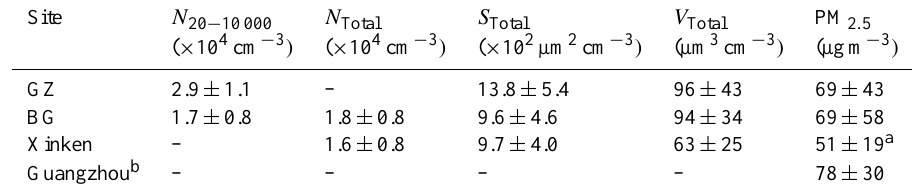
Table 2. Comparison of important particle properties (mean ± σ )